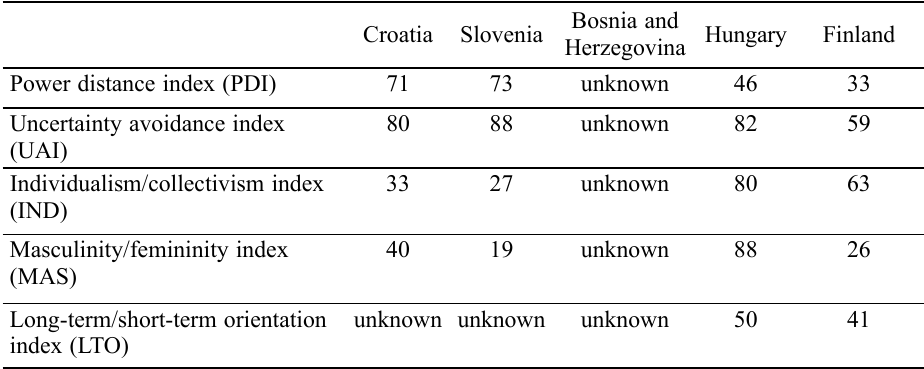
Table 2. The projected positions of Croatia and Slovenia, estimated values for Hungary and original values for Finland’s dimensions Bosnia and Croatia Slovenia Hungary Finland Herzegovina 71 73 unknown 46 33 88 unknown 82